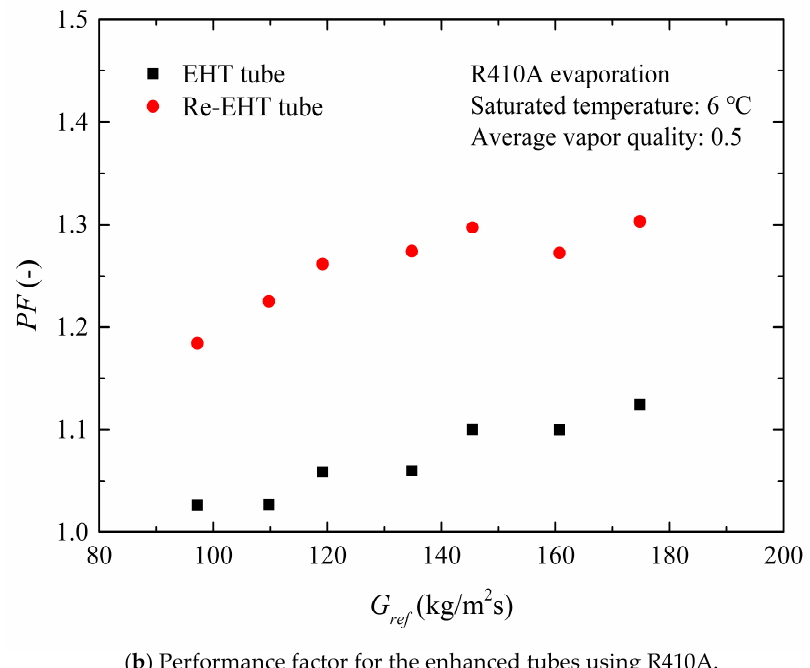
Figure 11. Performance factor versus mass flux for boiling heat transfer in the enhanced tubes using ( a ) R134A and ( b ) R410A.